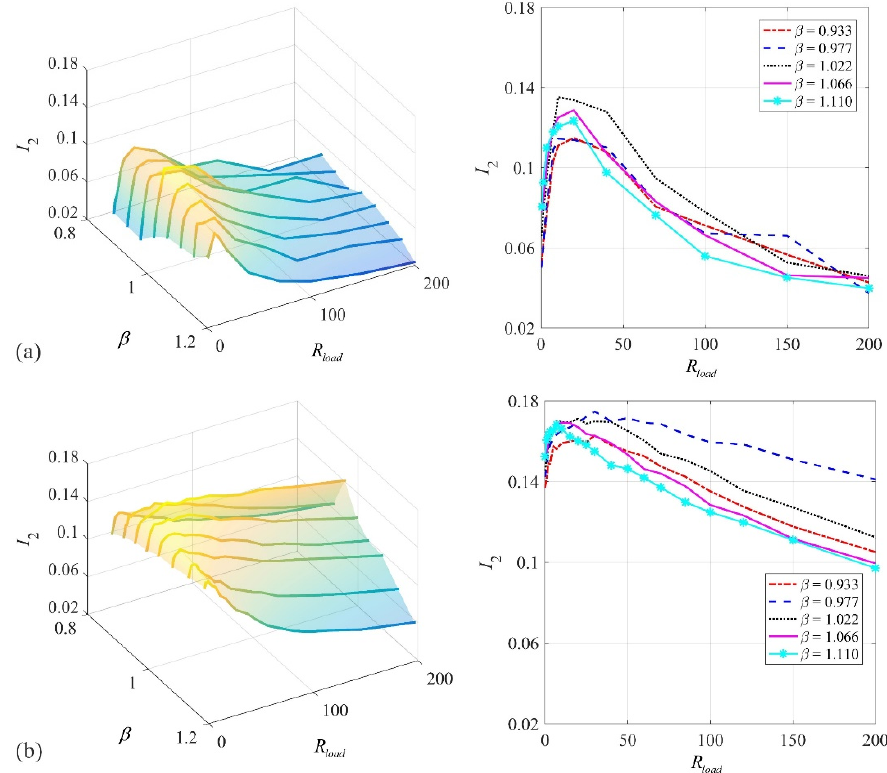
= 30.0 Ω in the = 50.0 Ω in the simulation and